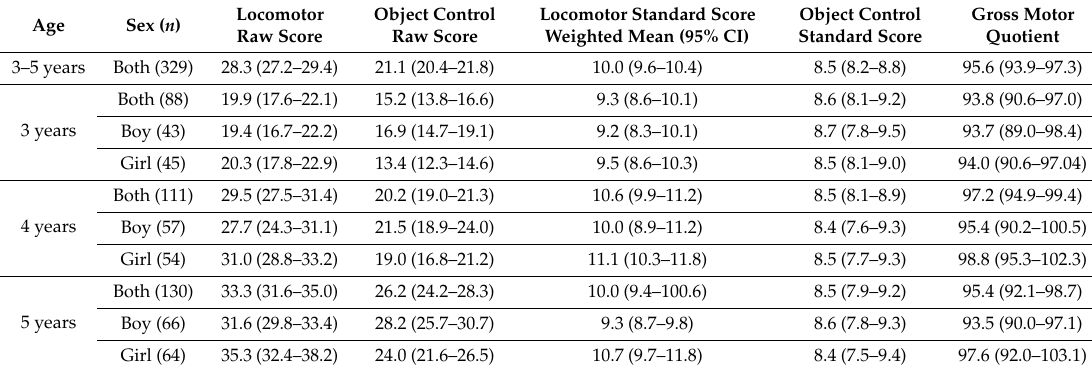
Table 1. Scores of gross motor